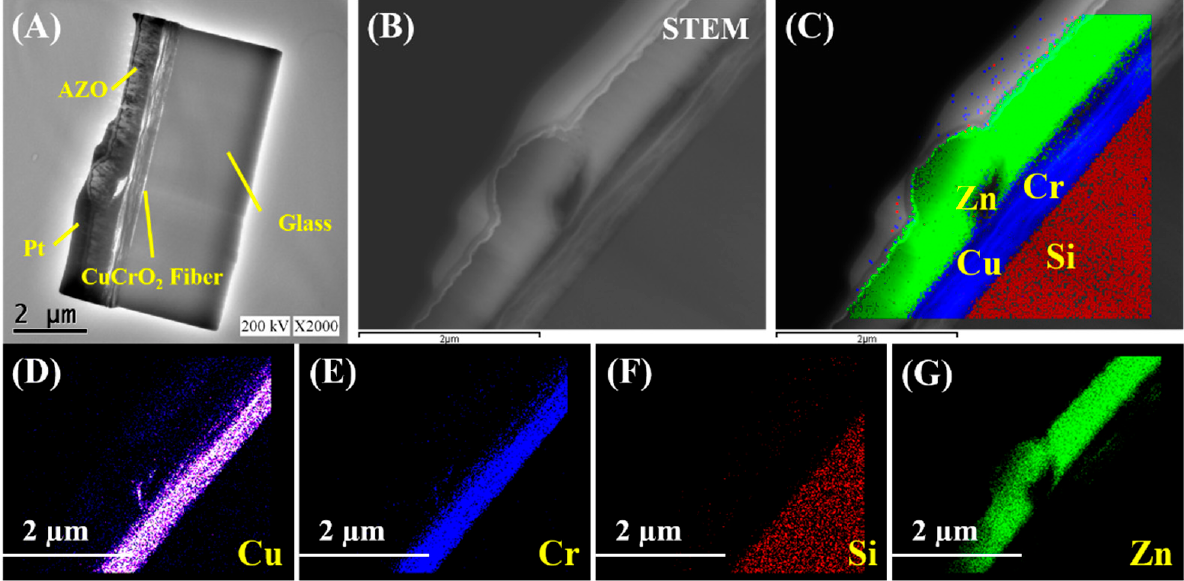
Figure 6. ( A ) TEM, ( B ) STEM, ( C ) Mix and EDX-mapping of the parallel direction of the electro-spun CuCrO 2 thin film prepared at rotating speed of 3000 rpm, ( D ) Cu, ( E ) Cr, ( F ) Al, ( G ) Zn.